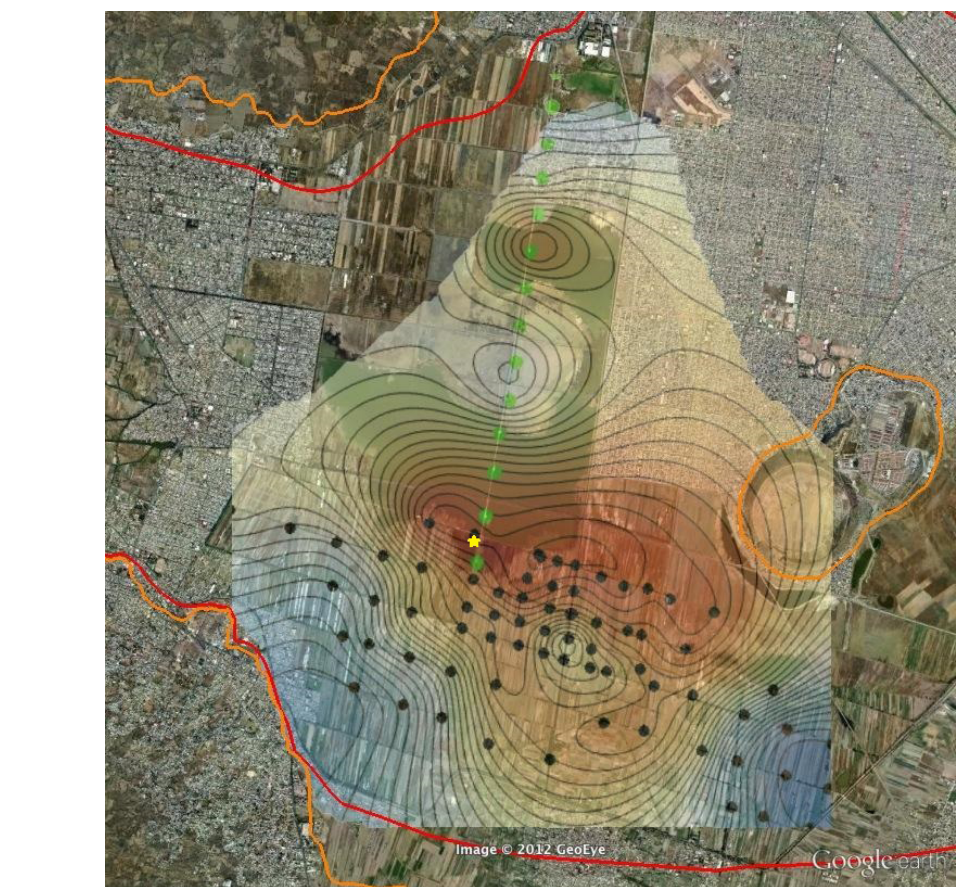
Figure 3. Thickness of the lacustrine sedimentary package below the Chalco sub-basin calculated from resonance frequencies determined from H/V spectral ratios. Red and orange lines represent contacts between the lacustrine and transitional geotechnical zones and between the transitional and the hillslope geotechnical zones, respectively (Gobierno del Distrito Federal, 2004). Water wells with known sediment thicknesses (Ortiz Zamora and Ortega Guerrero, 2010; green dots) were used as calibration points for individual passive seismic measure- ments (white dots). The color scale (blue–white–red) represents thicknesses of 0 (blue) to more than 300 (red) meters. The contour interval is 10m. The selected drill site (yellow star) was where this survey indicated the thickest sediment pile, just to the south of the existing lake. © 2012 GeoEye and © Google